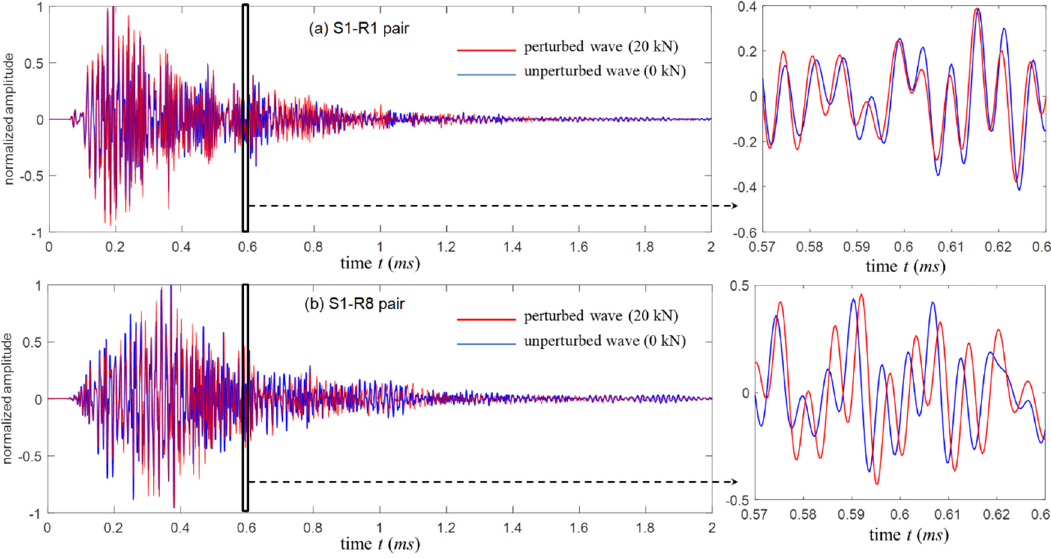
Figure 7. The averaged waveforms at 0 kN and 20 kN loads collected with: ( a ) the S1-R1 pair and ( b ) the S1-R8 pair.